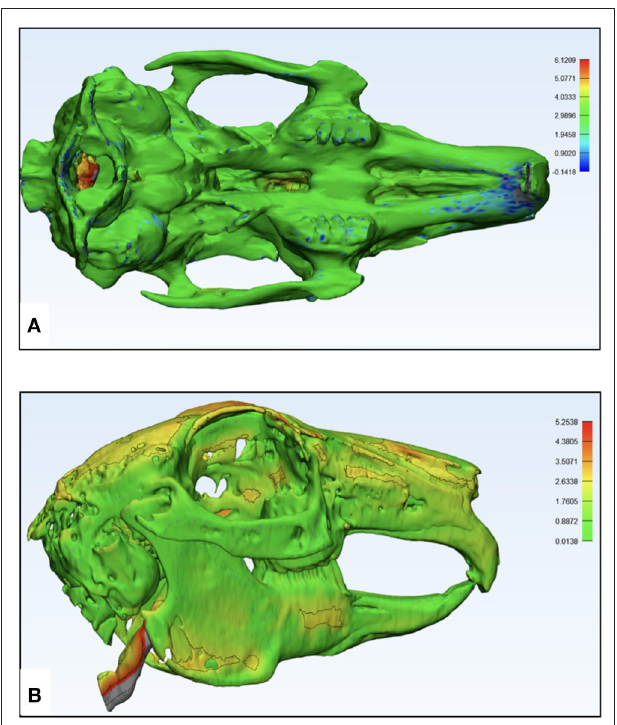
FIGURE 8 | Pictorial representation of the dimensional accuracy of the additively manufactured rabbit airway models using part comparison analysis in Materialize 3-Matic 13.0 software. The color codes green, yellow, orange, and red signify the accuracy of the overlapping points, which is quantified by the side bars. (A) µ CT-based model displaying an excellent overlap and a mismatch in the occipital part of the skull and (B) CBCT-based model displaying an excellent overlap and a minor surface mismatch.